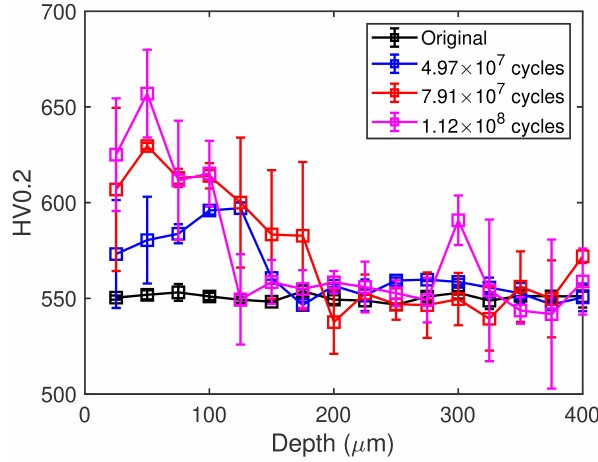
Figure 3. Subsurface Vickers hardness profiles of the RCF tested